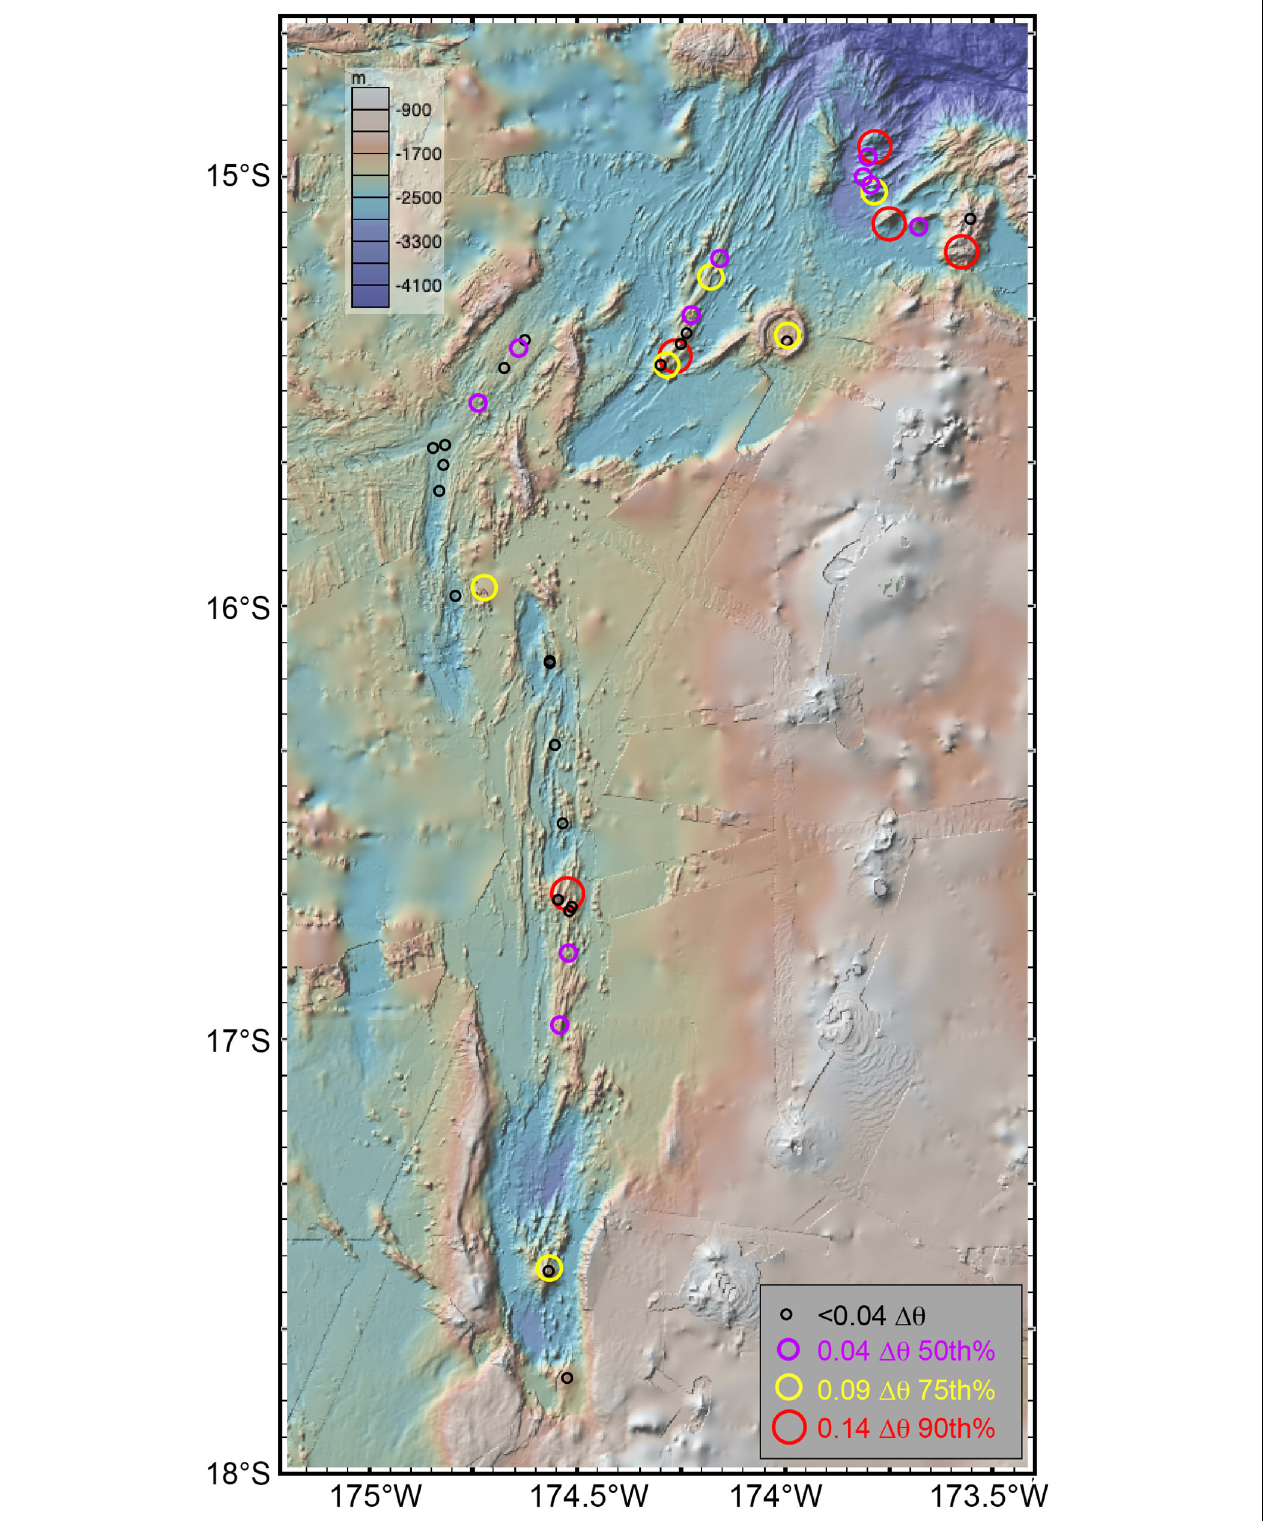
FIGURE 6 | Distribution of maximum (cid:49) θ ( ◦ C) at each site: ≥ 90th percentile (red), ≥ 70th–90th percentile (yellow), ≥ 50th–70th percentile (lavender), < 50th percentile (black). Values given in Tables 1 , 2 . Figure made with GeoMapApp (www.geomapapp.org).